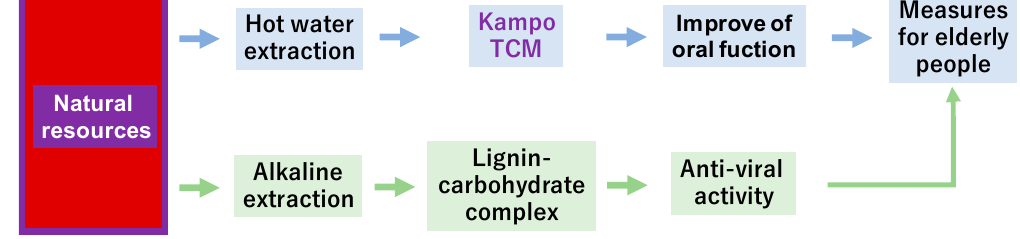
Figure 7. Supplementation of alkaline extract to Kampo prescription extends its therapeutic potential.